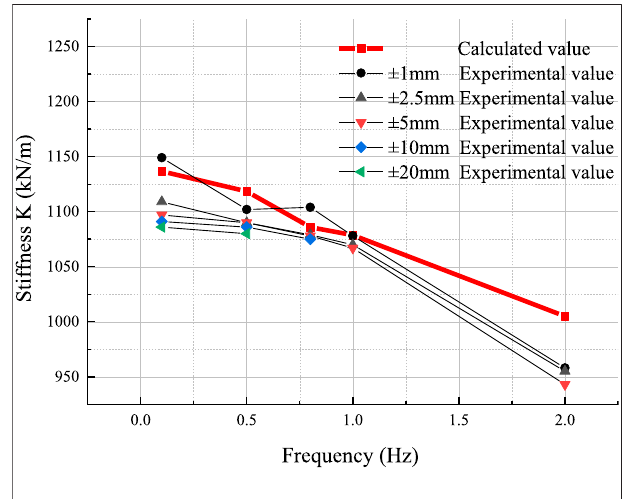
FIGURE 5 | Comparison between experimentally measured and calculated frequency-dependent stiffness.